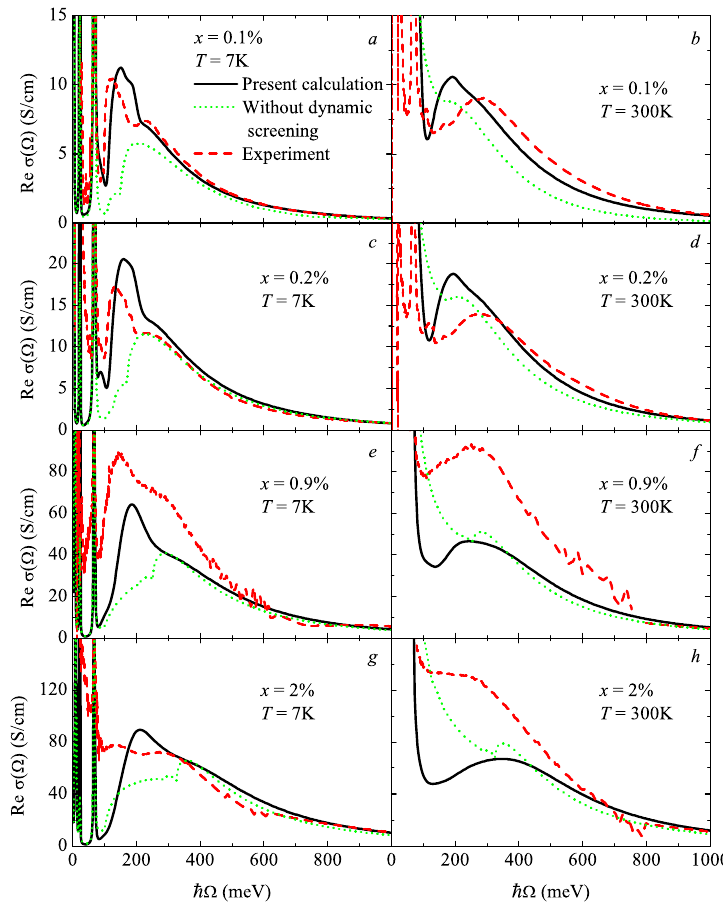
Figure 1. Many-polaron optical conductivity of n -doped SrTiO 3 in the mid-infrared frequency range for several values of the doping x and two temperatures (the parameters are indicated in the figure), corresponding to the experimental conditions of Ref. [2]. The calculated spectra (solid curves) are compared with the experimental data (dashed curves). Dotted curves show the results of Ref. [13]. The subgraphs correspond to the following cases: in ( a , b ) doping relative concentration is x = 0.1%, for T = 7 K ( a ) and T = 300 K ( b ). The panels ( c , d ), ( e , f ), ( g , h ), describe the results for x = 0.2%, x = 0.9% and x = 2%,